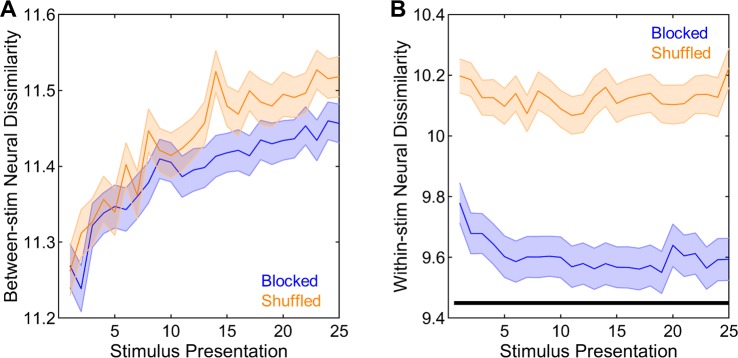
Neural dissimilarities in blocked and shuffled sequences.(A) Between-stimulus neural dissimilarities across stimulus presentations were comparable between the two sequences. (B) Within-stimulus neural dissimilarities in the blocked sequence were markedly lower than those in the shuffled sequence. Shadings indicate SEMs. Horizontal black bar denotes significant differences.